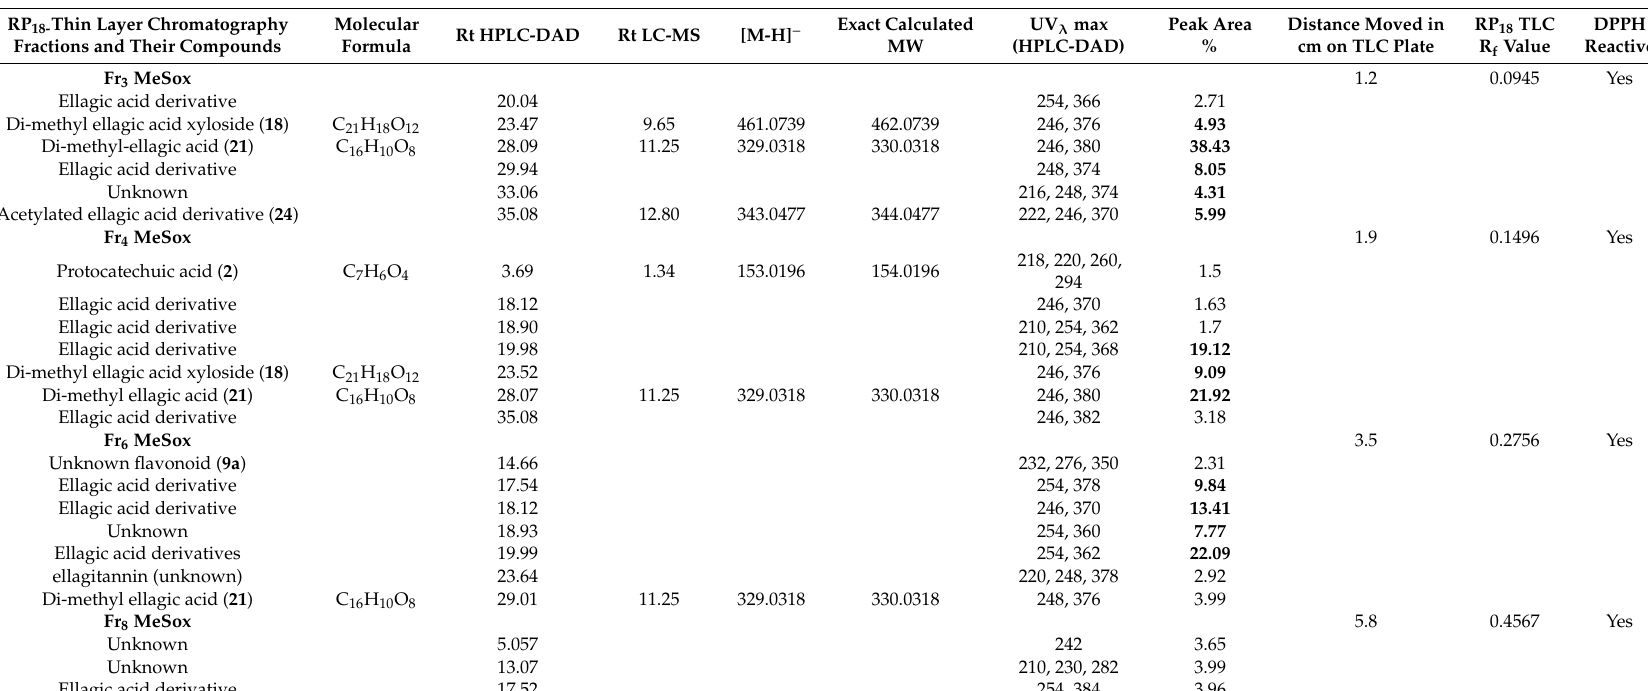
Table 3. HPLC-DAD, UHPLC / QTOF-MS and RP 18 TLC data of fractions obtained from a methanol Soxhlet root extract of A. leiocarpa . Some compounds numbered according to the HPLC-DAD chromatograms in Figure